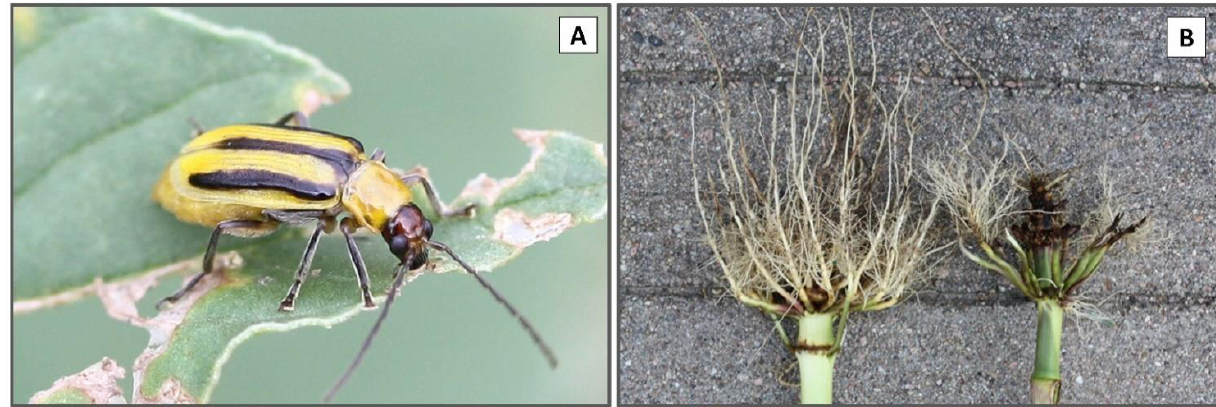
Figure 1. ( A ) Adult Diabrotica virgifera virgifera LeConte; ( B ) example of severe root injury from Diabrotica virgifera virgifera LeConte (Dvv) larval feeding that can occur when Dvv larval density is high (right) versus uninjured root (left); photos by L. J. Meinke.